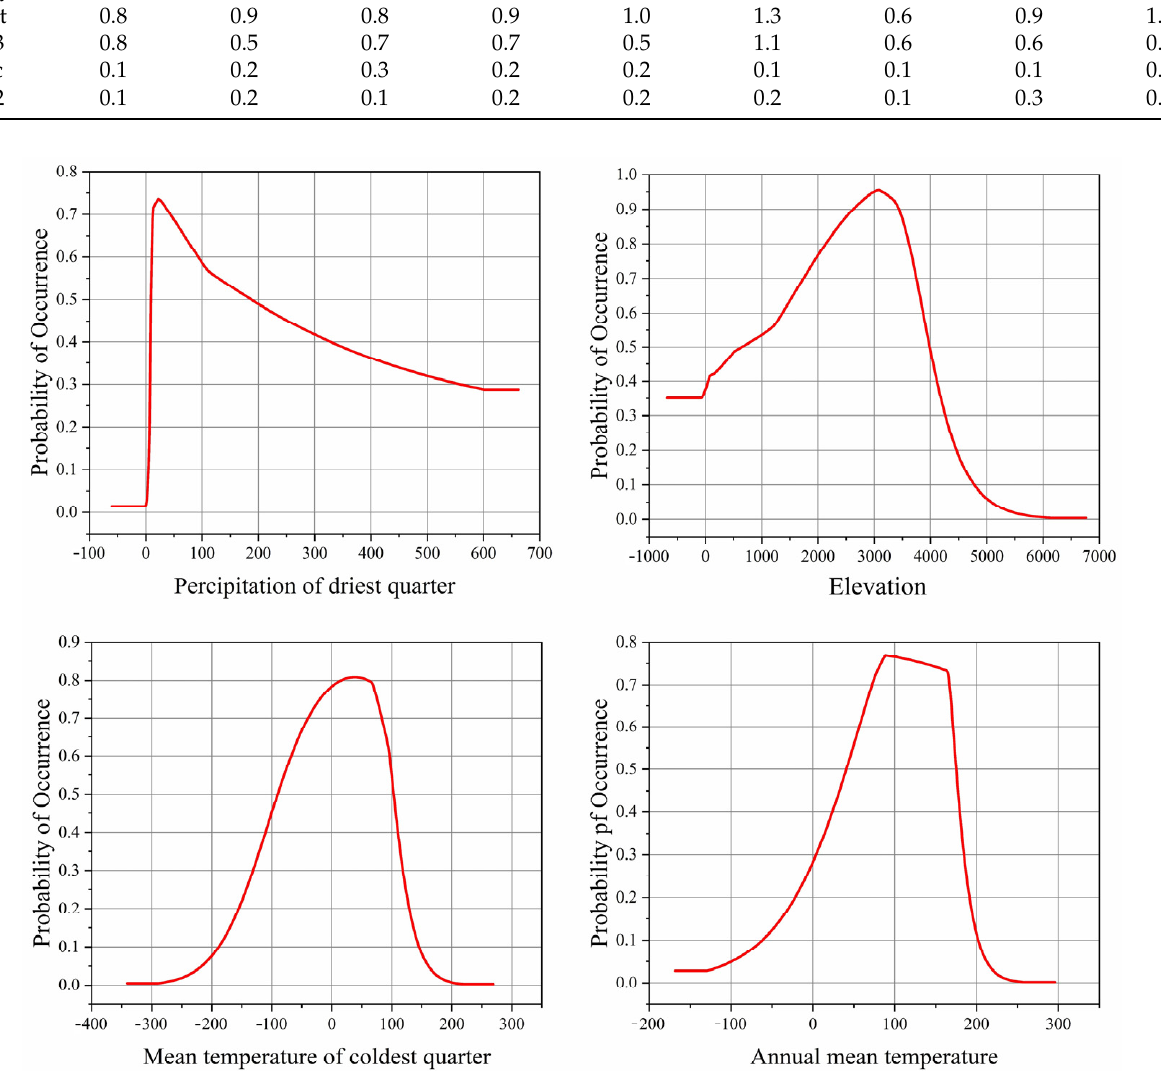
Figure 2. Single-factor response curves to the main environment factors.